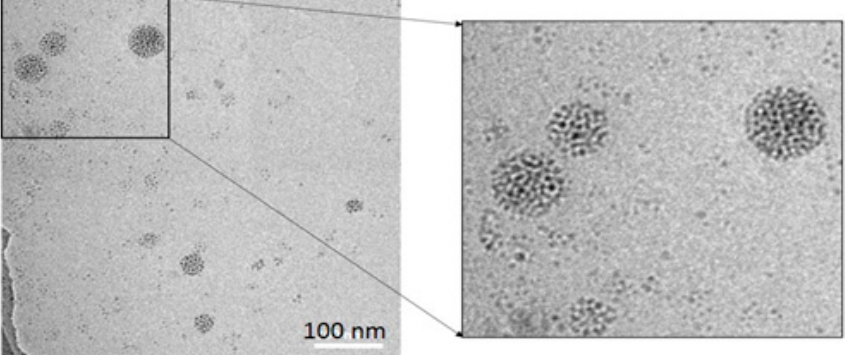
Figure 1. A typical TEM photograph of SiQD-De/F127 nanoparticles. The 40–70 nm diameter cores made up of assembled SiQDs-De (contrasted in the picture) are encapsulated with a Pluronic F127 molecule.